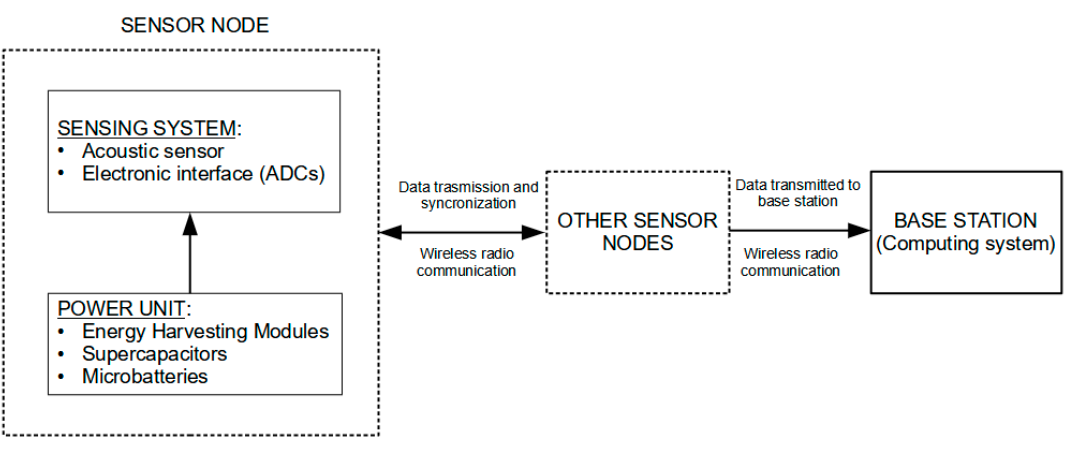
Figure 13. A block diagram of a wireless autonomous sensor network for SHM connected to a base station.